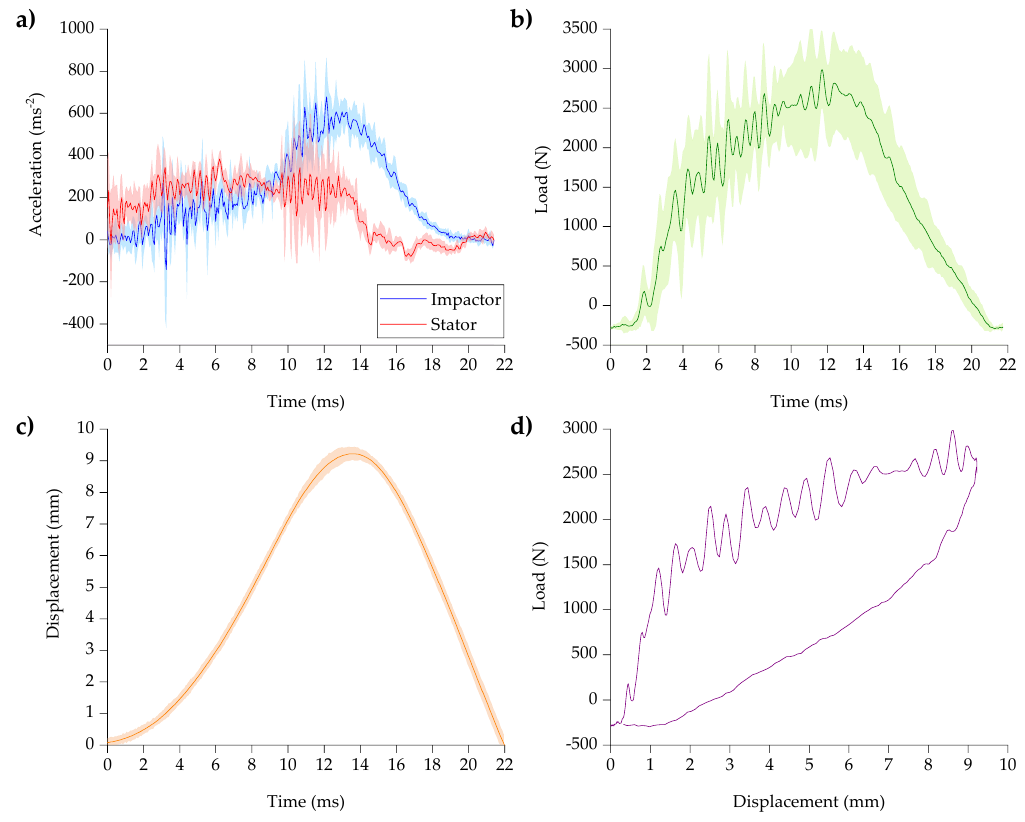
Figure 3. Compression impulse of Arpro 5130 foam: ( a ) impactor and stator acceleration, ( b ) compressive load measured by the load cells, ( c ) displacement from high speed camera, ( d ) load-displacement curve.